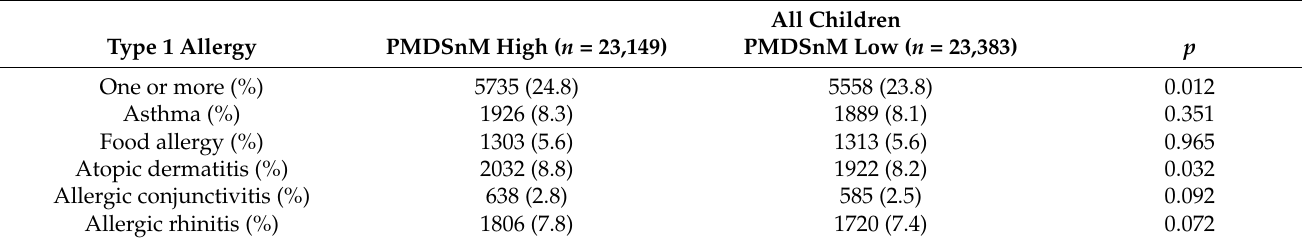
Table 6. Comparison of the allergic outcomes between the two PMDSnM groups. All